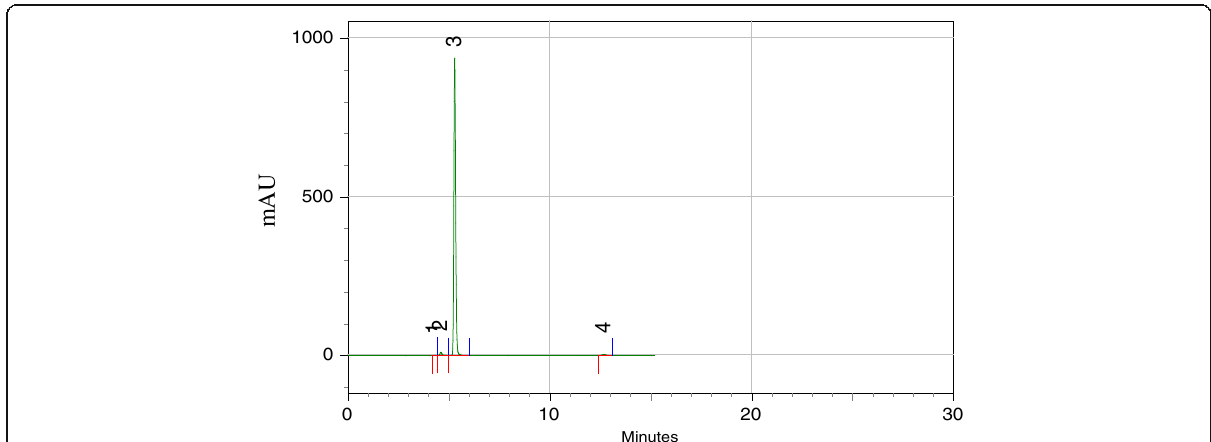
Fig. 3 High-performance liquid Chromatography (HPLC) of zerumbone crystals. HLPC elution of zerumbone crystal with retention time of ~ 5 min confirmed zerumbone purity of 98% (peak 3)